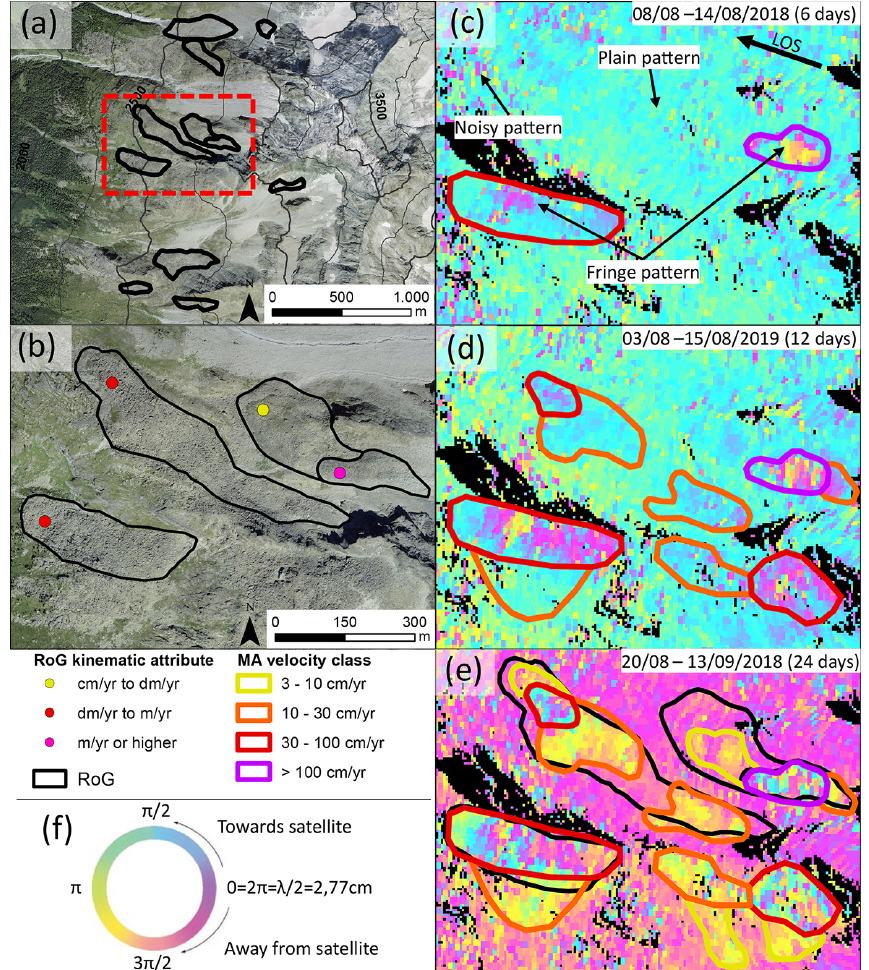
Figure 3. Example of a RoGI in the Arolla region (location: 46 ◦ 2 (cid:48) 24 (cid:48)(cid:48) N, 7 ◦ 30 (cid:48) 36 (cid:48)(cid:48) E, 2750ma.s.l.), Swiss Alps (a) ; outlines of RoG are in black, and the location of an investigated area (a) is in red. Orthoimages from © Google Earth 2019. (c–e) Sentinel-1 interferograms from the descending orbit, including examples of InSAR signal patterns; layover and shadow areas are masked out (black). Two MAs are detected on the 6d interferogram (c) . Using 12 and 24d, additional MAs are visible (d, e) . This is an example where the MA outlines do not fully match the geomorphological outline of the RoGs. MAs (SE-border) not related to RoG are visible and mapped. Based on MAs, the kinematic attributes are assigned to RoGs (b) . Fringe cycle related to the change of colour (f) ; a complete fringe cycle is equivalent to a change of half a wavelength (2.77cm for Sentinel-1) in the LOS